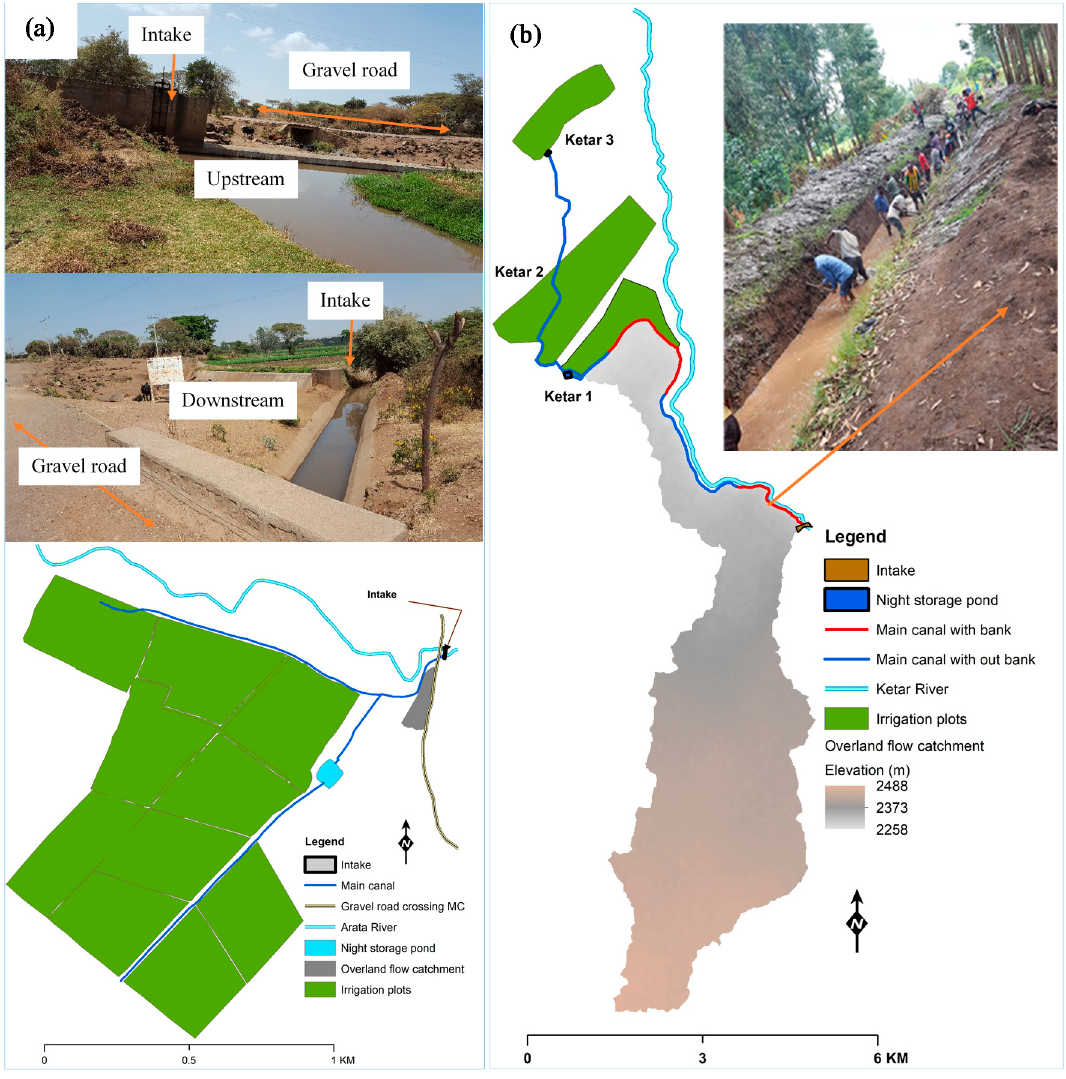
Figure 12. Layout of irrigation schemes and overland sediment flow in contributing catchment: ( a ) Arata-Chufa and ( b ) Ketar. At Ketar, the main canal segments labeled ‘with bank’ have a ridge embankment that helps protect the canal against overland sediment inflow.